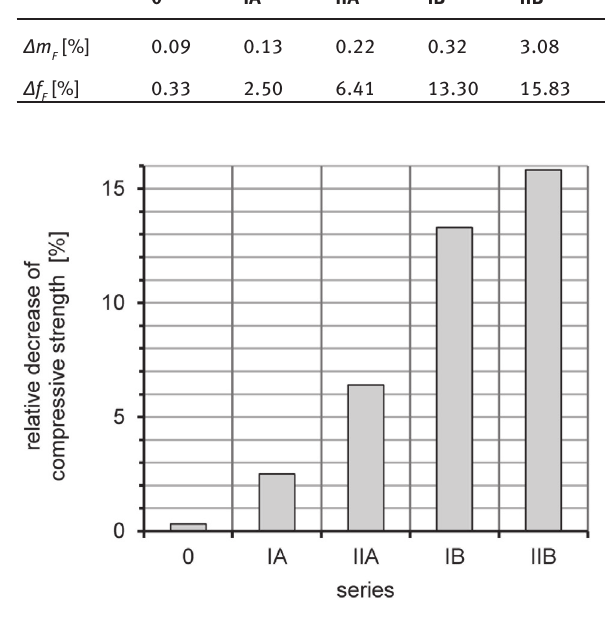
Figure 8: Relative strength